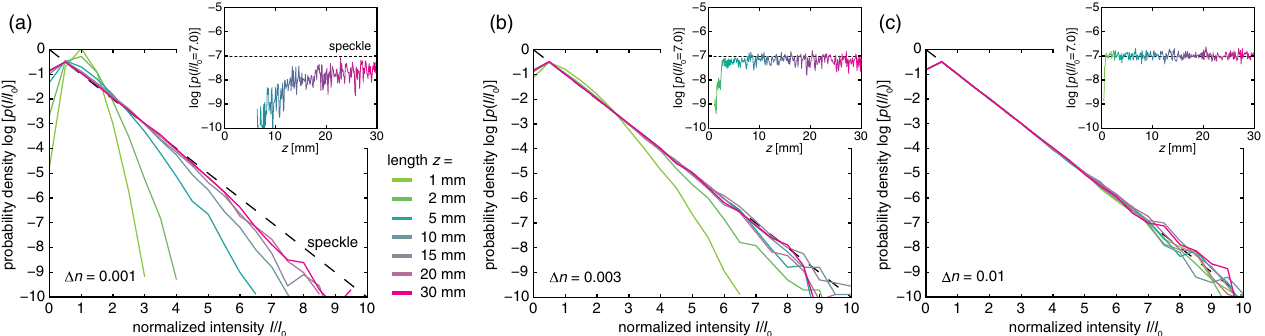
FIG. 14. Results of numerical simulations based on the beam propagation method (BPM) for a normally distributed refractive index ¼ 20 μ m, l ¼ 3 μ m and variance Δ n ¼ 0 . 001 (a), Δ n ¼ 0 . 003 (b), and Δ n ¼ 0 . 01 (c). When the index variation with l corr ; ∥ corr ; ⊥ variation is strong enough to cause a random superposition of deviated field components, the intensity profile exhibits characteristics of a speckle pattern and the probability density function becomes an exponentially decaying curve [black dashed line in accordance with Eq. (1)]. No abundance of extreme events can be observed here in contrast to our